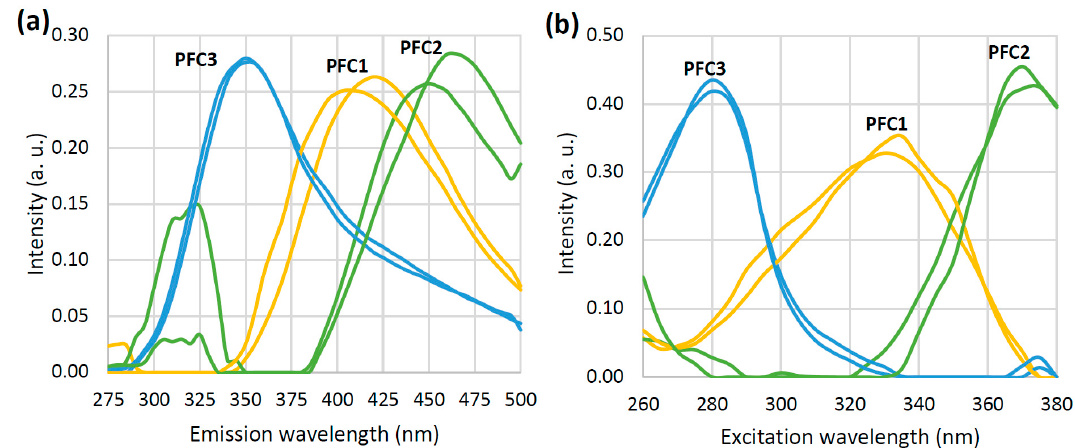
Figure 4. Emission ( a ) and excitation ( b ) loading vectors for the three PARAFAC components (PFC1–PFC3) obtained by the split-half